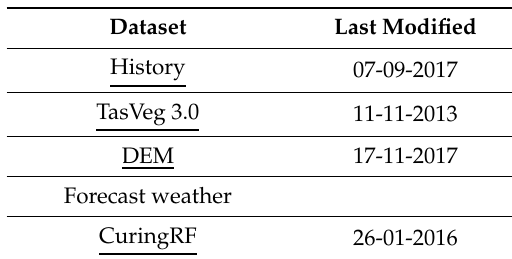
Table 12. Data source and